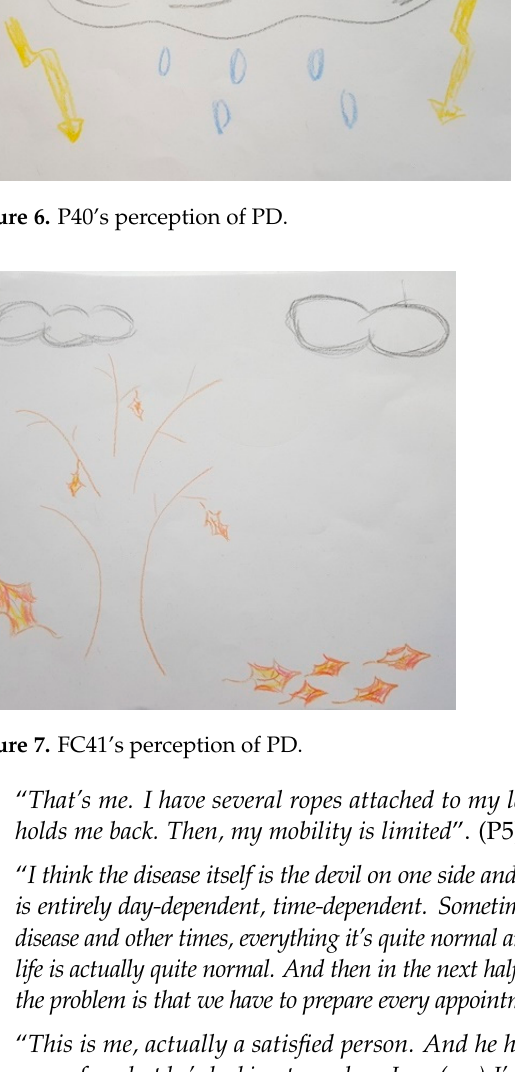
Figure 6. P40’s perception of PD.